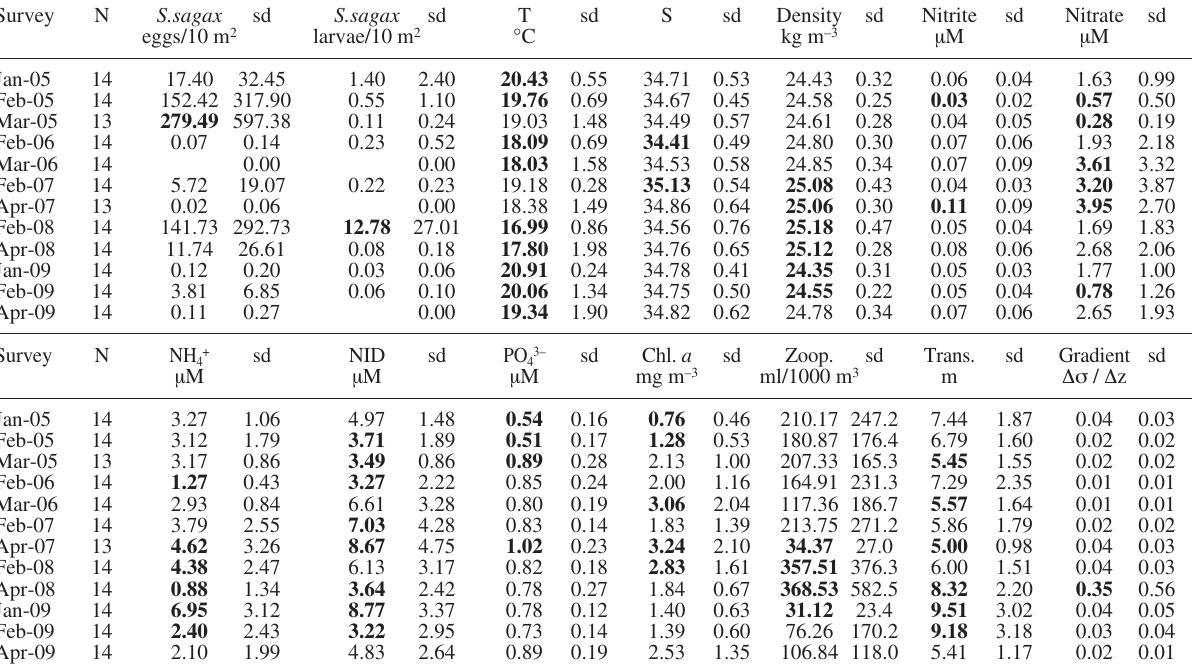
Table 1. – Sardinops sagax egg and larval mean abundance, and mean and standard deviation (sd) of hydrological variables during winter and early spring 2005-2009 in Bahía Magdalena, Baja California Sur. Chl. a , chlorophyll a ; S, salinity; T, temperature; Trans., transparency; Zoop., zooplankton. Survey